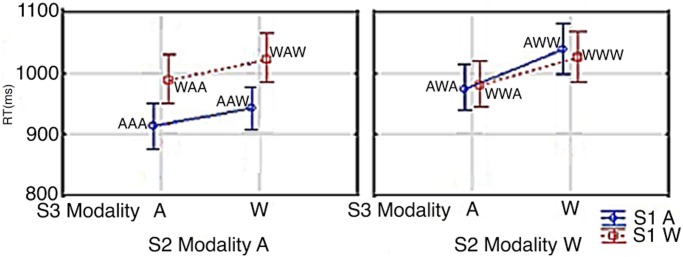
S3 Modality x S1 Modality x S1 Modality.Vertical bars denote 0.95 confidence intervals for repeated measures ANOVA (Hollands & Jarmasz, 2009). S1, S2 & S3 modality is signified by ‘A’ and ‘W’; ie. Arabic Digit (A) vs. Written Number Word (W). As an example, WAW signifies a written number word at S1 and S3 and an Arabic digit at S2.